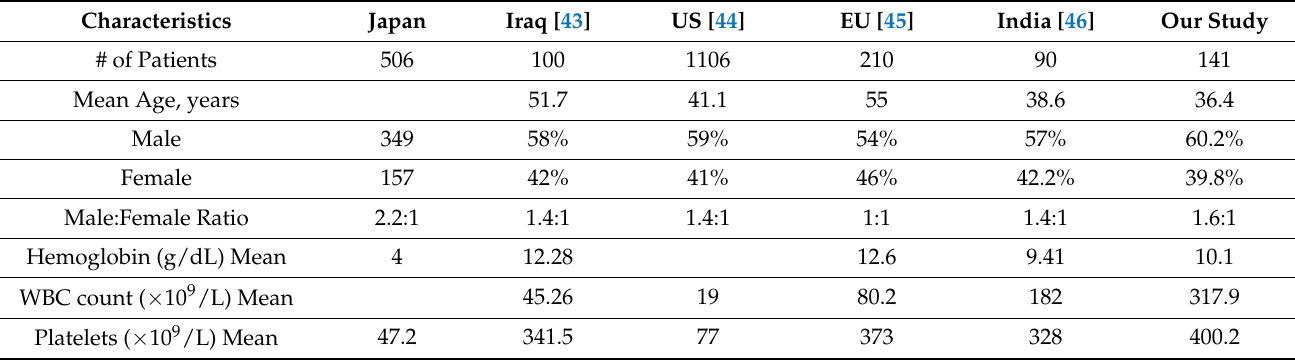
Table 3. Comparisons between our findings and other studies.